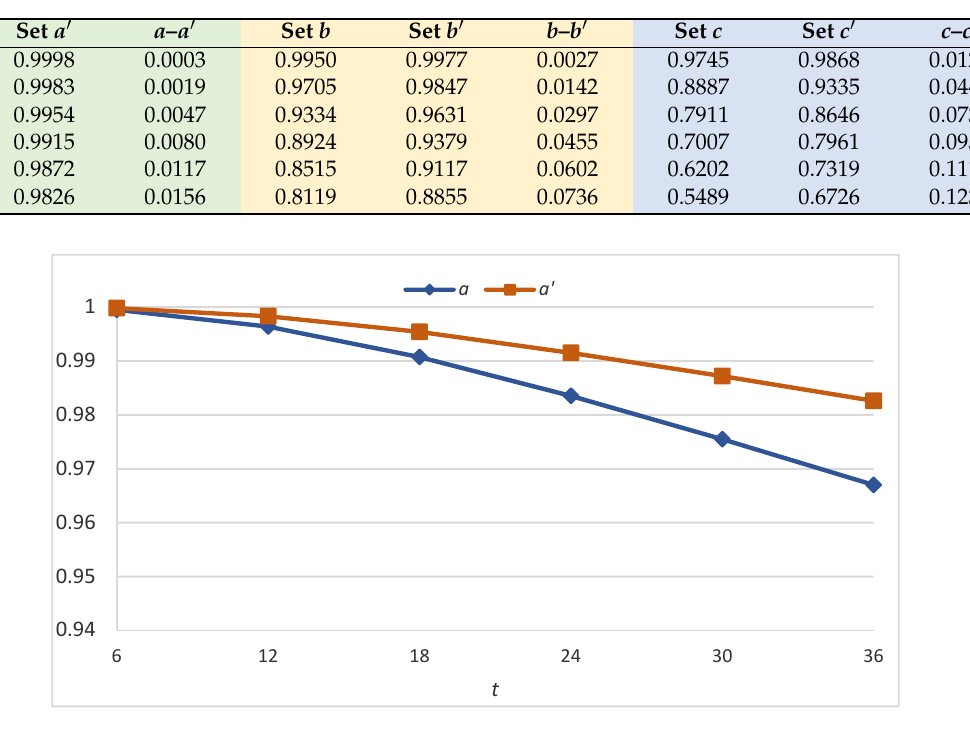
Figure 2. Bitcoin dependability before and after the application of the DDAA under sets a and a ′ .